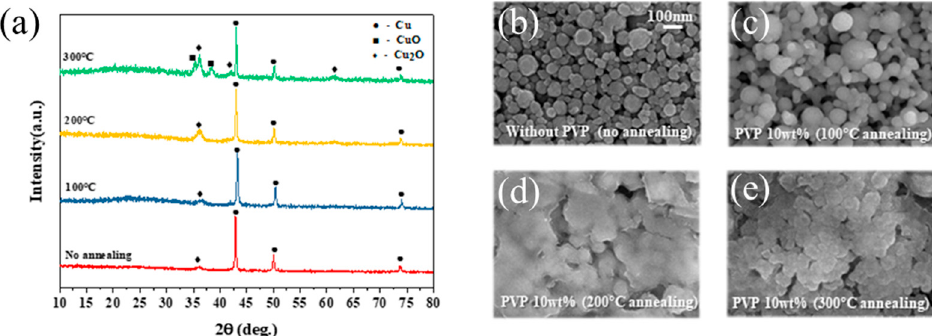
Figure 9. ( a ) XRD patterns of the ink-jet printed Cu conductive layer on a photo-cured SiO 2 insula- tion layer after the annealing process and SEM images; ( b ) no annealing; ( c – e ) with PVP after an- nealing at 100 °C, 200 °C, and 300 °C.